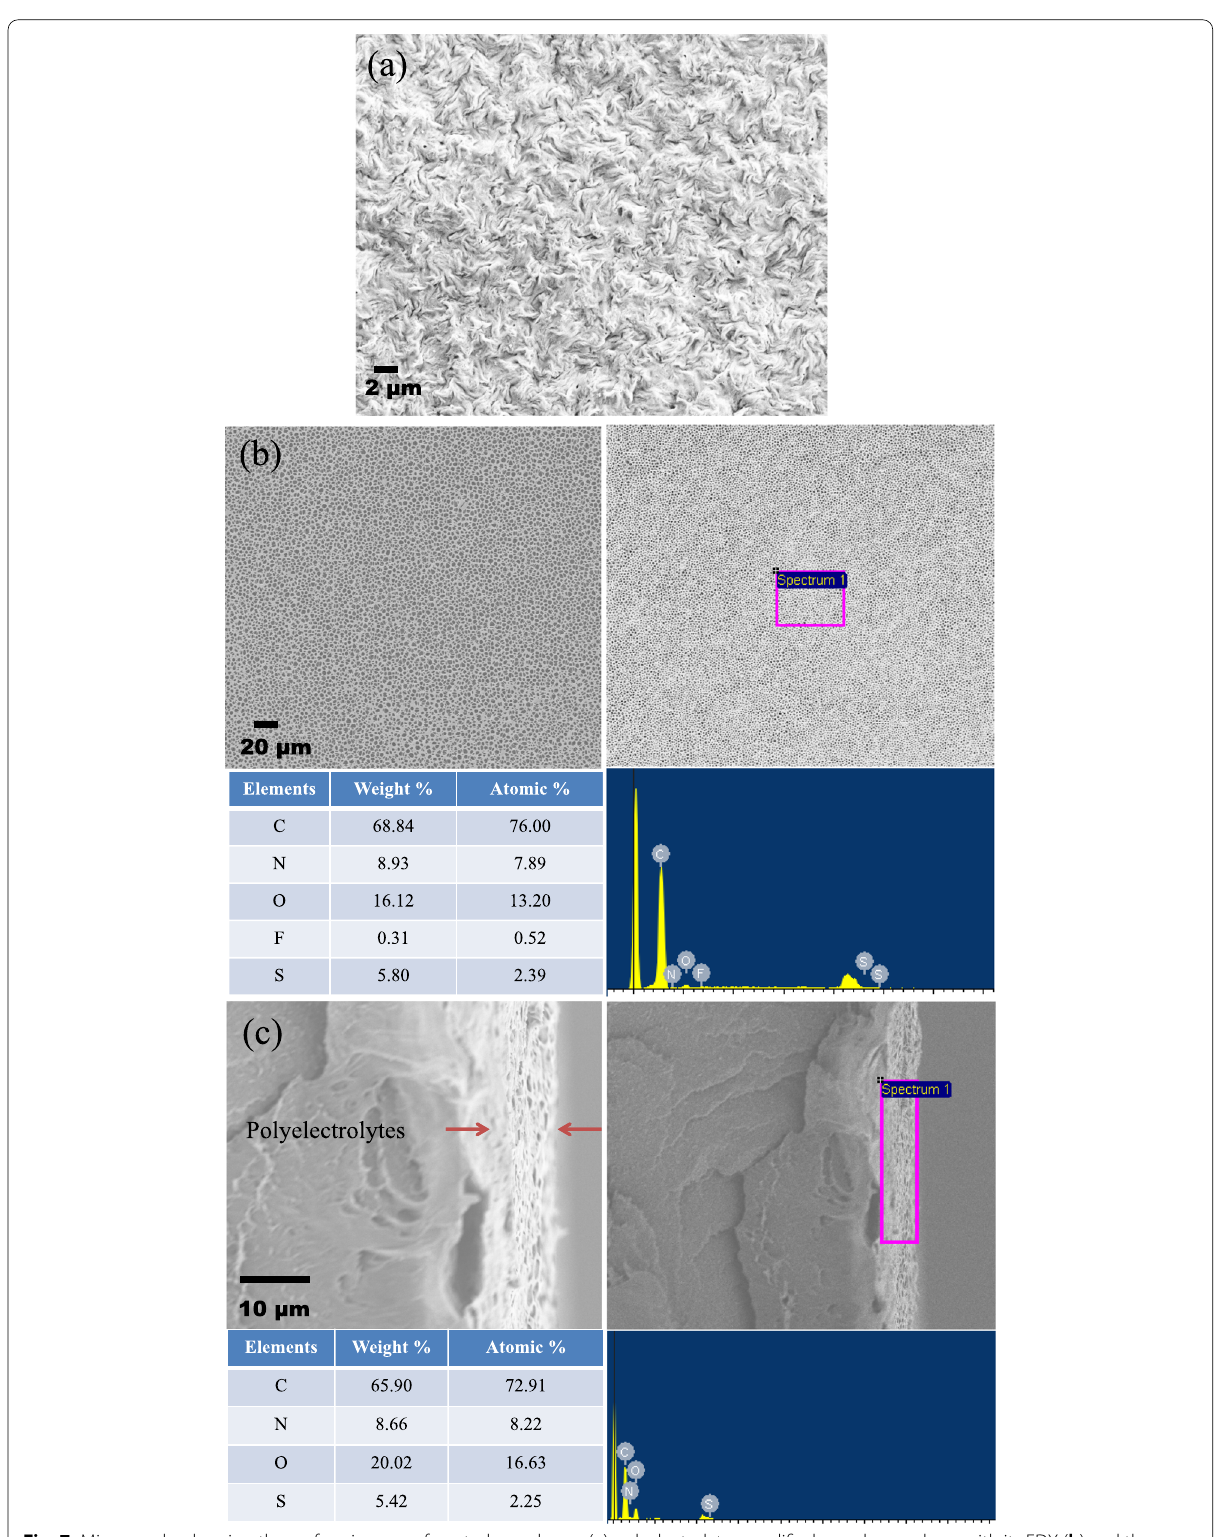
Fig. 7 Micrographs showing the surface images of control membrane ( a ) polyelectrolytes modified membrane along with its EDX ( b ) and the cross-section image of polyelectrolytes modified membrane along with its EDX ( c